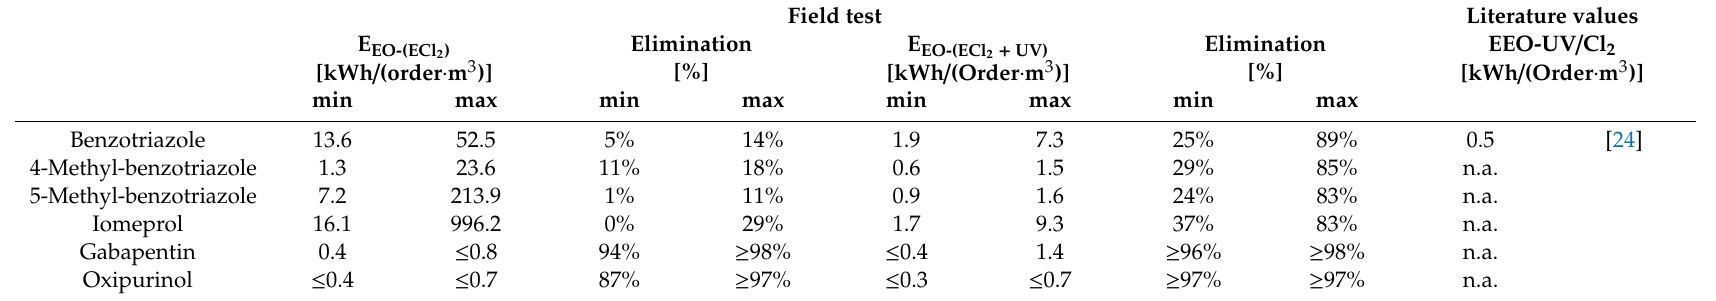
Table A1. E EO values achieved during field tests with Elbe river water considering ECl 2 and UV / ECl